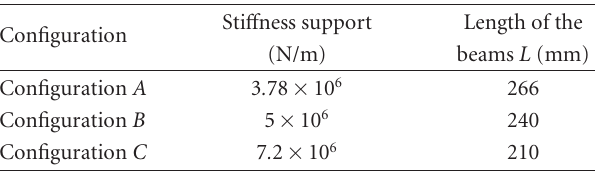
Table 1: Values of the sti ff ness support for the three configurations of the experimental